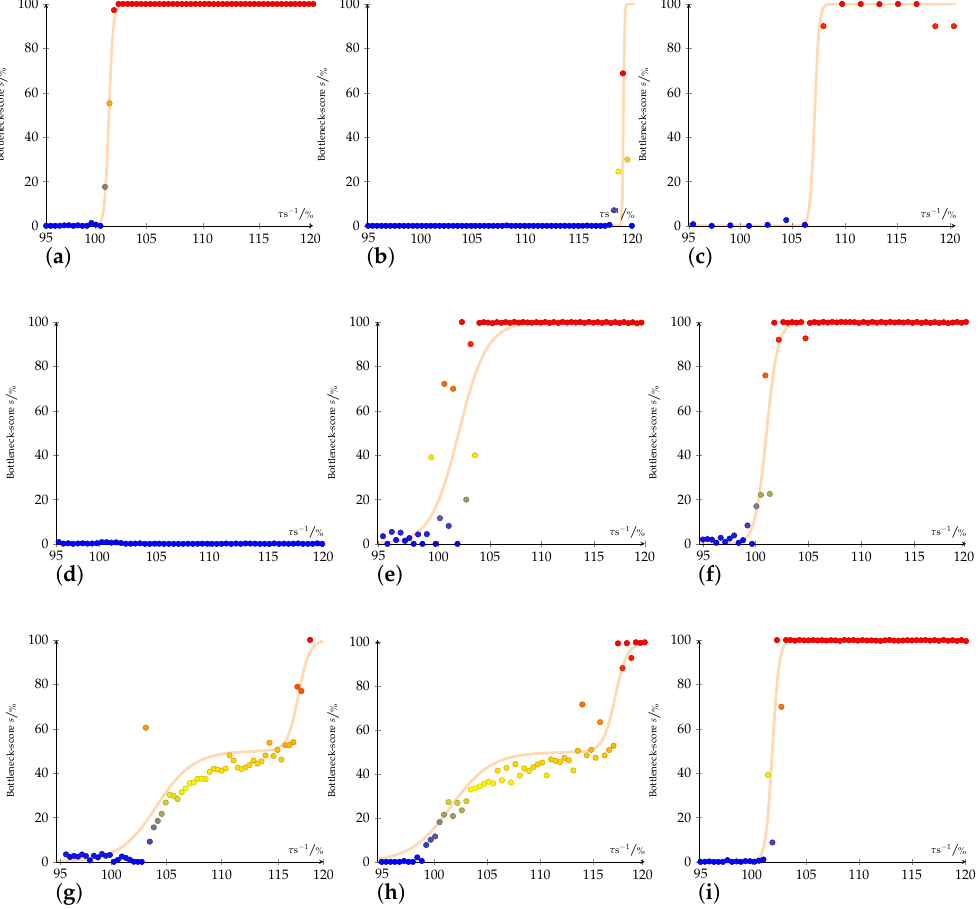
Figure 8. Variation of the cycle times from 95% to 120% for each machine. ( a ) Variation of machine M1. ( b ) Variation of machine M2. ( c ) Variation of machine M3. ( d ) Variation of machine M4. ( e ) Variation of machine M5. ( f ) Variation of machine M6. ( g ) Variation of machine M7. ( h ) Variation of machine M8. ( i ) Variation of machine